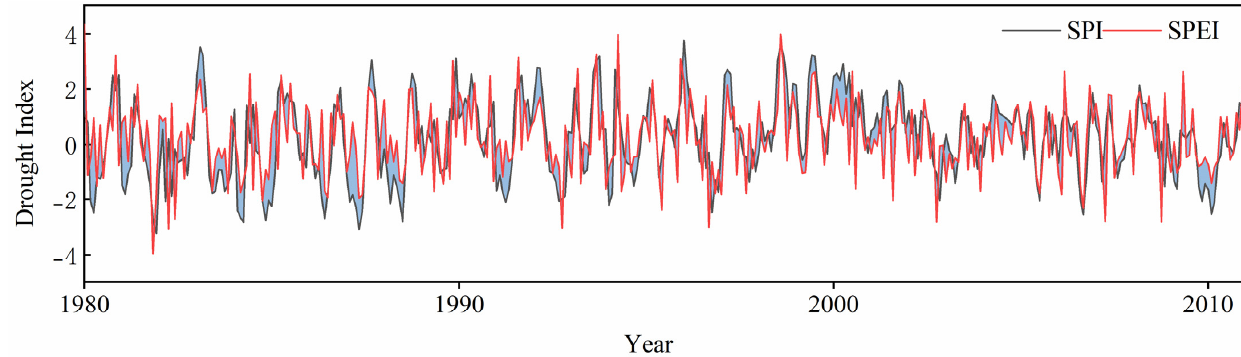
Figure 8. Comparison of the SPI with the SPEI.